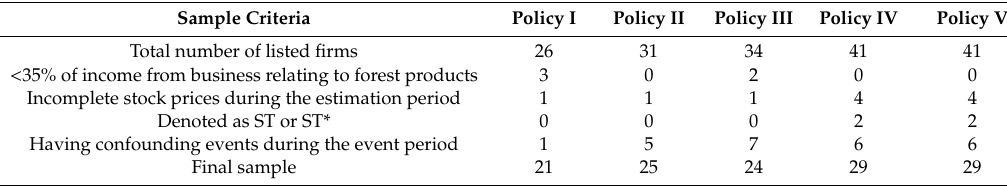
Table 1. Data-screening process.